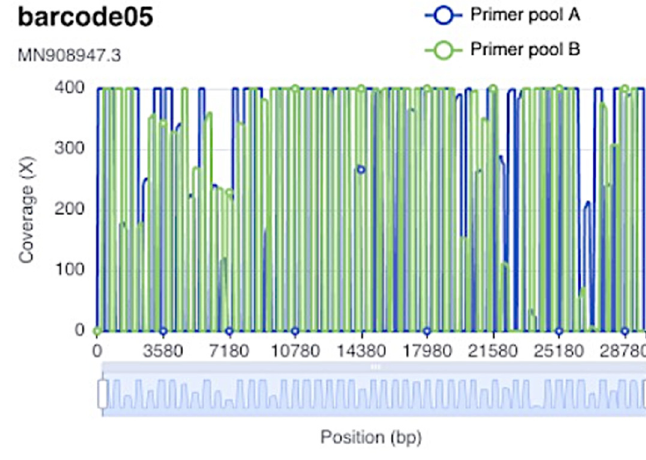
Figure 2. Example of coverage for barcode 5 from round 6.